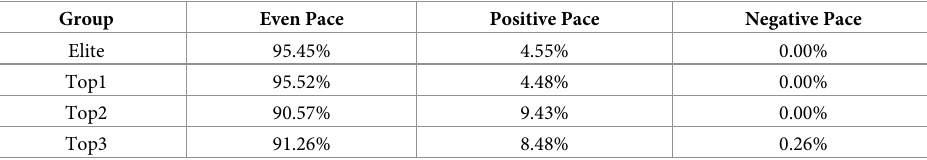
Table 5. Relation between pacing profiles and athletes‘group for